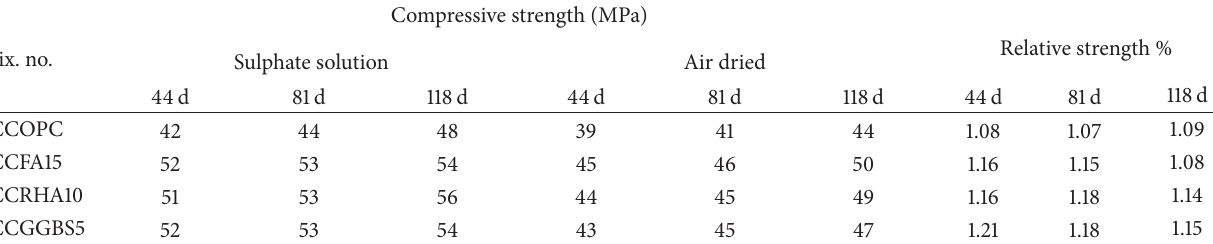
Table 6: Effect of MS on the strength with air drying SCC.